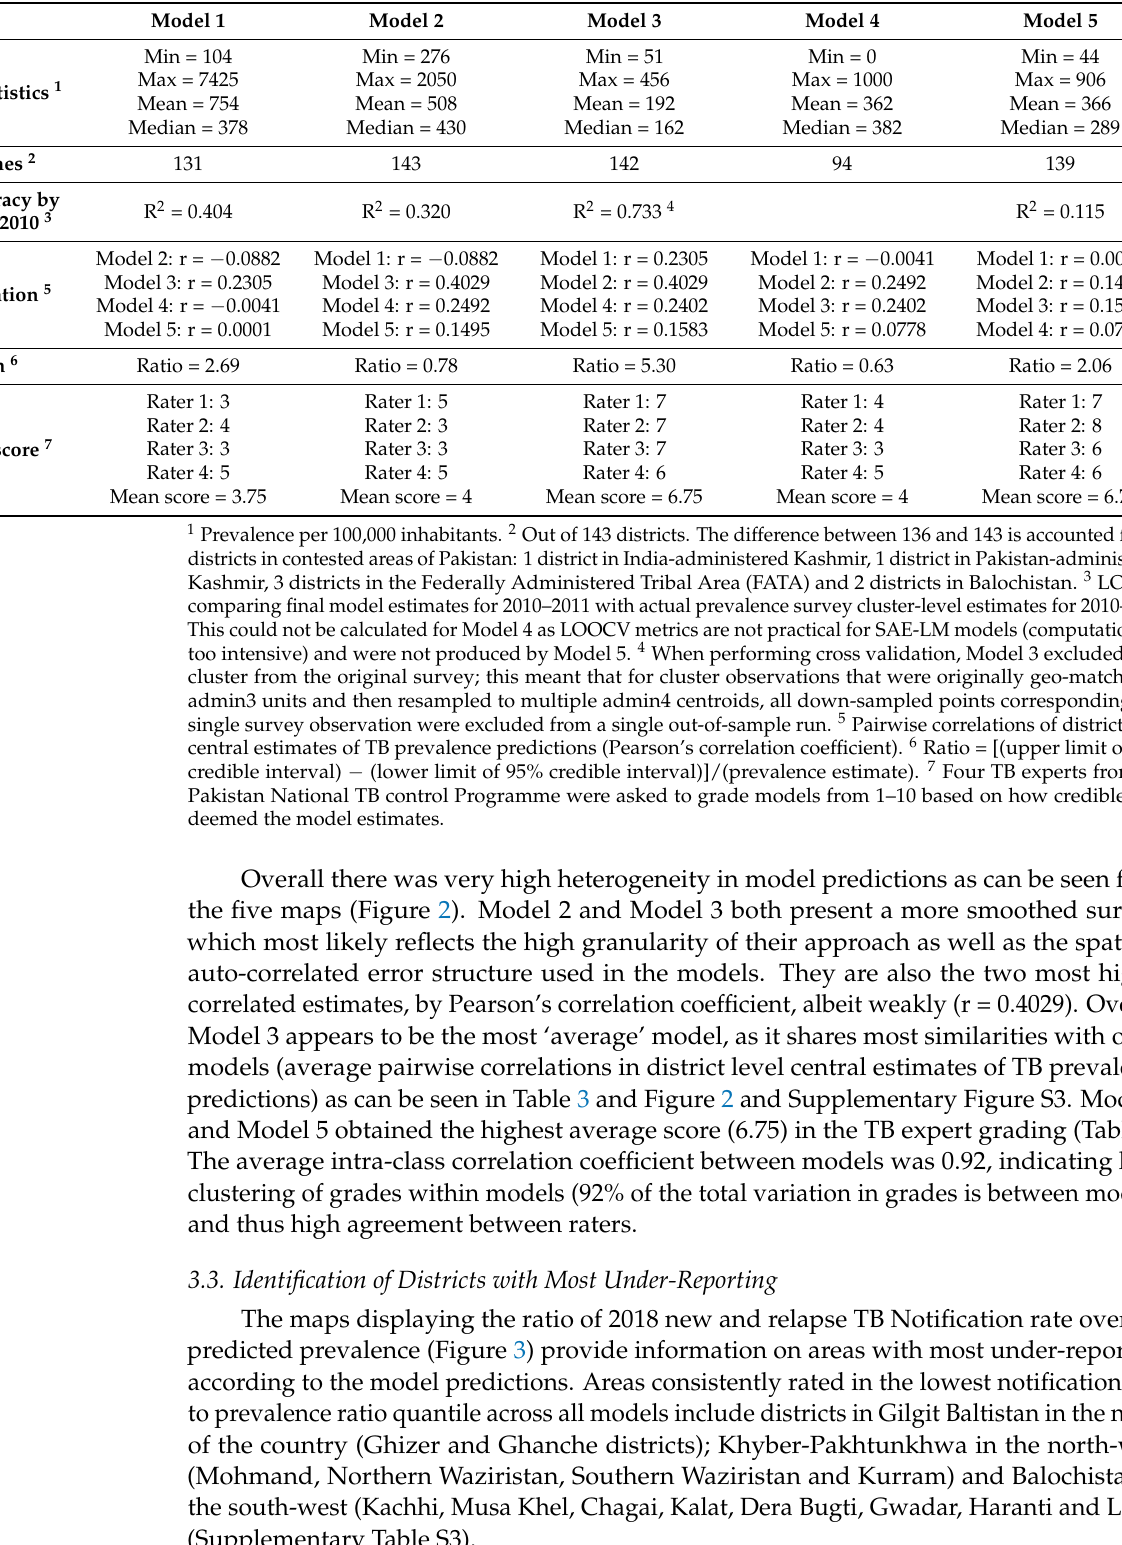
Table 3. Predictions: data quality